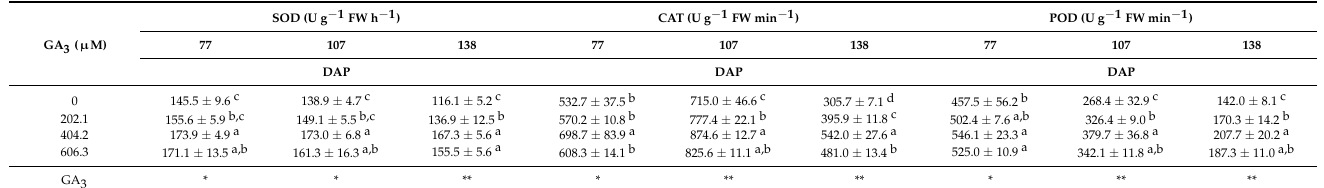
Table 4. The effects of GA 3 level on the SOD, CAT and POD of sesbania pea leaves at three growing dates grown in saline soils.